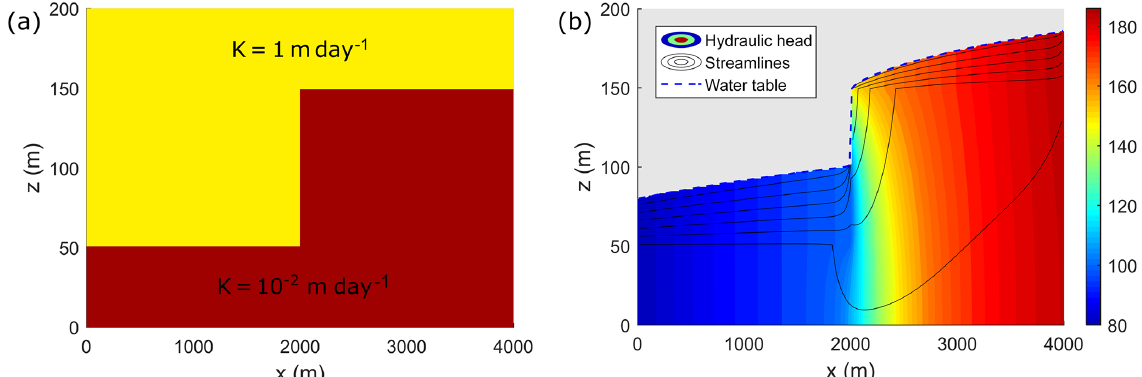
Figure 5. Impact of a difference in basement elevation induced as a result of faulting on hydraulic head in a hypothetical setting. (a) Hydraulic conductivity in a vertical cross section representing a sedimentary layer overlying a basement with significantly lower hydraulic conductivity, with the fault zone itself having no different hydraulic conductivity (i.e. the fault only implies the difference in basement elevation). (b) Re- sults from an unconfined groundwater flow simulation in which a constant head (80m) was specified on the left boundary and inflow was specified on the right boundary (at a rate proportional to the hydraulic conductivity). A sharp difference in hydraulic head is observed across the fault zone. The simulation was performed using MODFLOW-NWT (Niswonger et al., 2011), with 200 cells in horizontal direction and 150 cells in the vertical